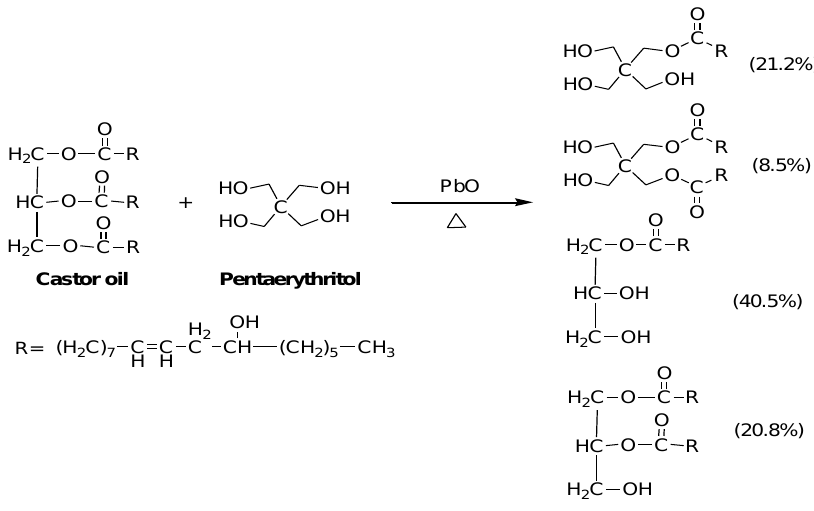
Scheme 1. Reaction scheme for obtaining